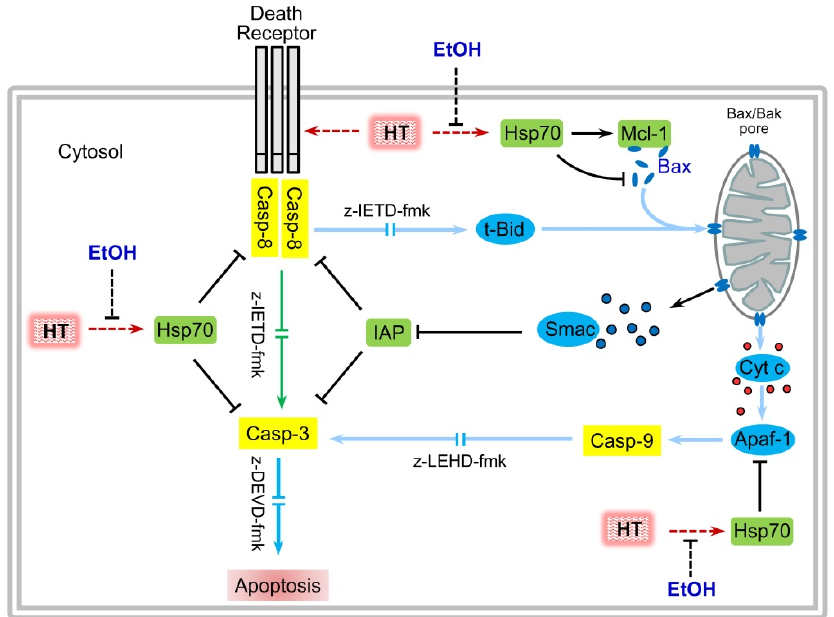
Figure 7. Ethanol enhances apoptotic cell death triggered by hyperthermia on human leukemia cells. Hyperthermia (HT) treatment alone stimulates apoptosis through a mechanism involving mainly caspase-8 and caspase-3 activities and increases the levels of the survival factor HSP70 which is able to: (i) stabilize the anti-apoptotic factor Mcl-1, (ii) to block Bax translocation and apoptosome for- mation (via binding to Apaf-1) and (iii) to inhibit caspase-8 and caspase-3. Ethanol abrogates hyper- thermia-induced HSP70 expression, leading to an increase in caspase-8 activity, hydrolysis of Bid, translocation of Bax, release of mitochondrial factors (cytochrome c and Smac) and finally increase in caspase-9 and caspase-3 activities. Cyt c, cytochrome c; z-IETD-fmk, caspase-8 inhibitor,